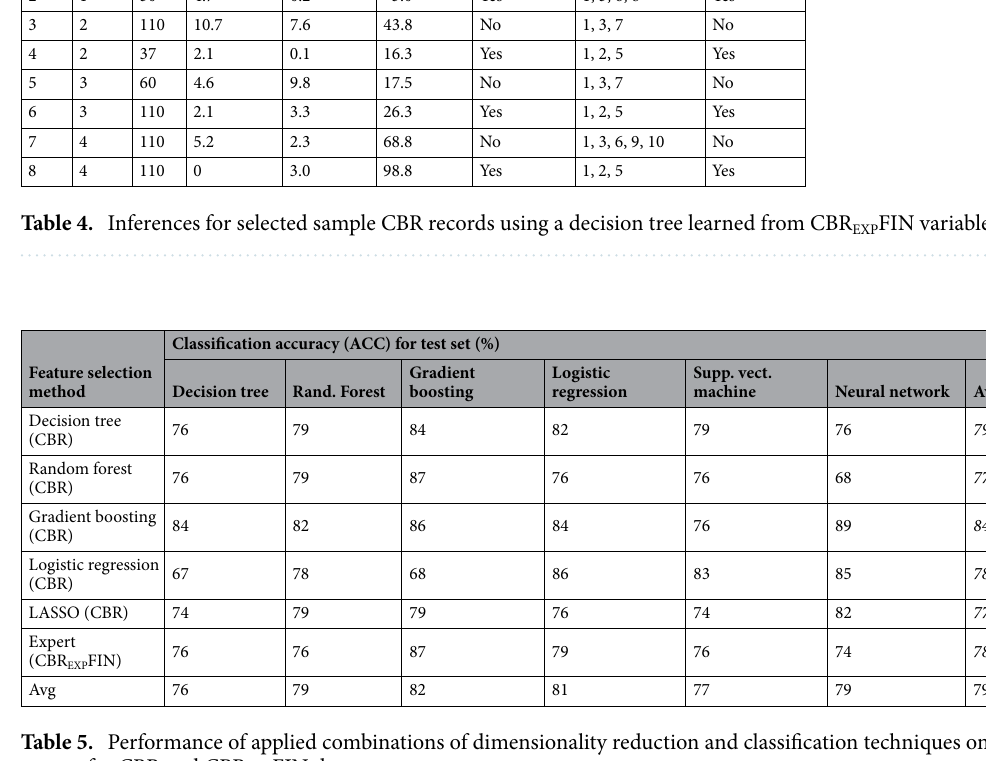
Table 5. Performance of applied combinations of dimensionality reduction and classification techniques on test set for CBR and CBR EXP FIN data.